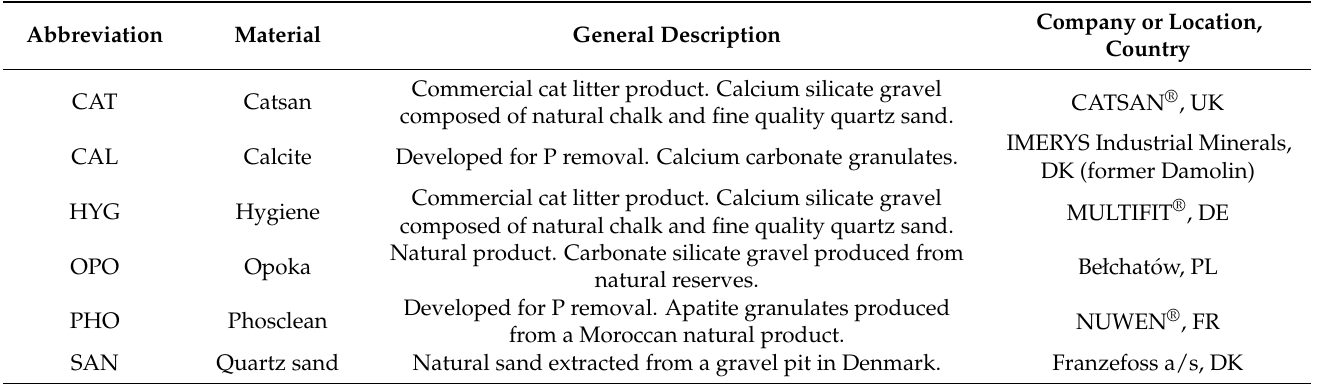
Table 1. Information for the six non-coated materials included in the screening experiment.